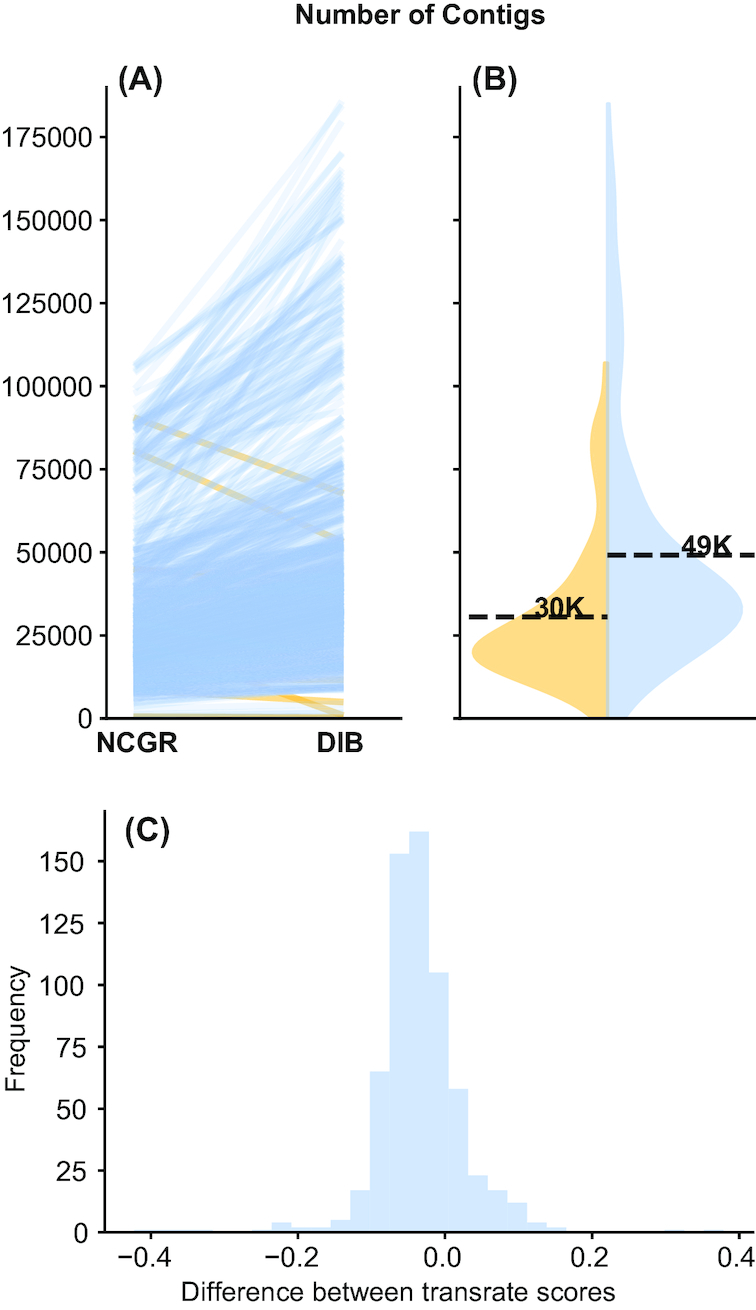
The number of contigs and Transrate quality score for each dataset varied between DIB and NCGR assemblies. (A) Slope graphs show shifts in the number of contigs for each individual sample between the DIB and the NCGR assembly pipelines. Negative slope (yellow) lines represent values where NCGR was higher than DIB and positive slope (blue) lines represent values where DIB was higher than NCGR. (B) Split violin plots show the distribution of the number of contigs in each assembly with the original assemblies from NCGR in yellow (left) and the DIB re-assemblies in blue (right side of B). (C) The difference in Transrate score between the DIB and NCGR assemblies is shown as a histogram. Negative values on the x-axis indicate that the NCGR assembly had a higher Transrate score, and positive values indicate that the DIB assembly had a higher Transrate score.